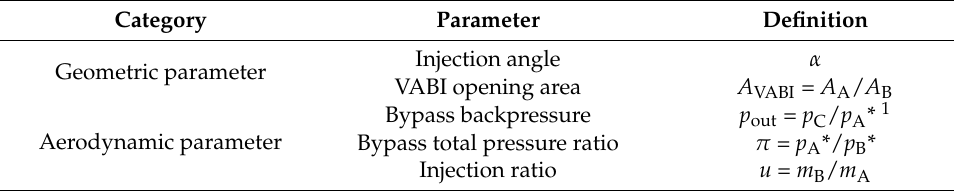
Table 1. Feature parameters for the VABI aerodynamic